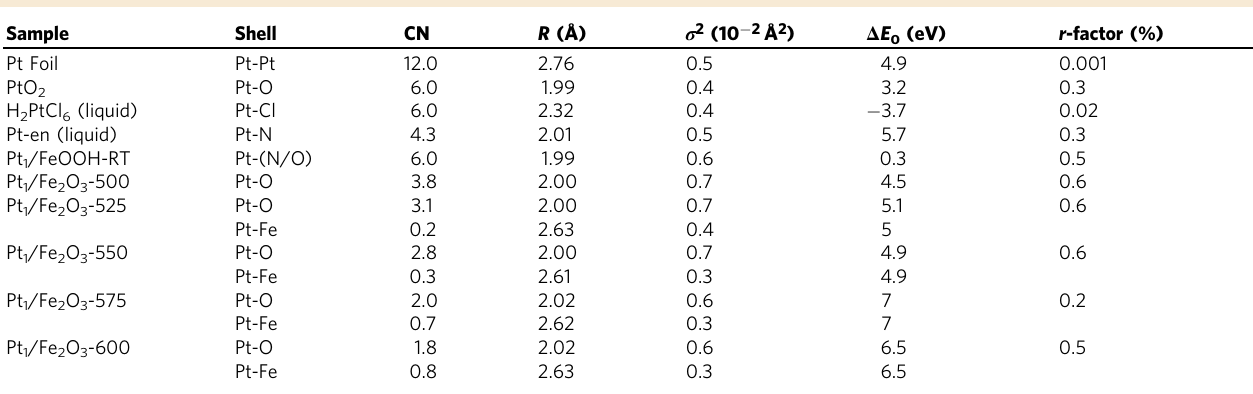
Table 1 The best- fi tted EXAFS results of Pt 1 /Fe 2 O 3 -T catalysts a